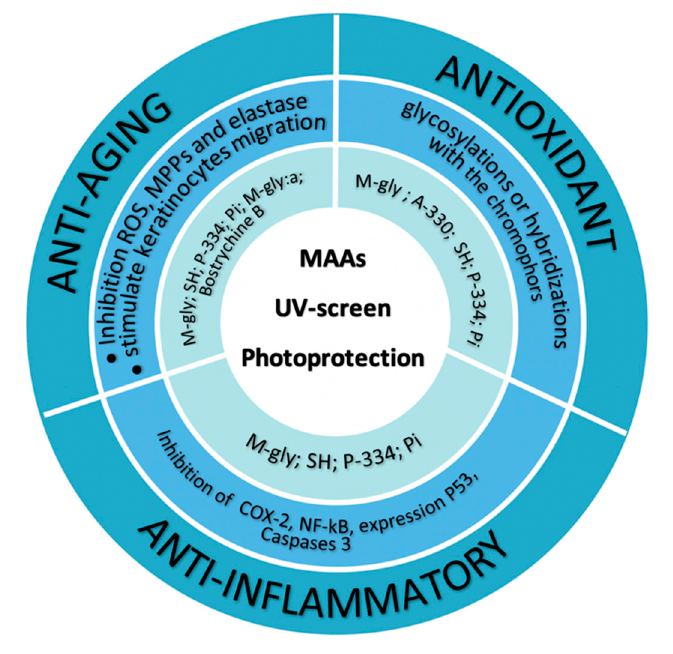
Figure 5. Scheme of the different bioactivities described in MAAs, indicating the relevance of some MAAs [33,41,47,123,127,142–155].